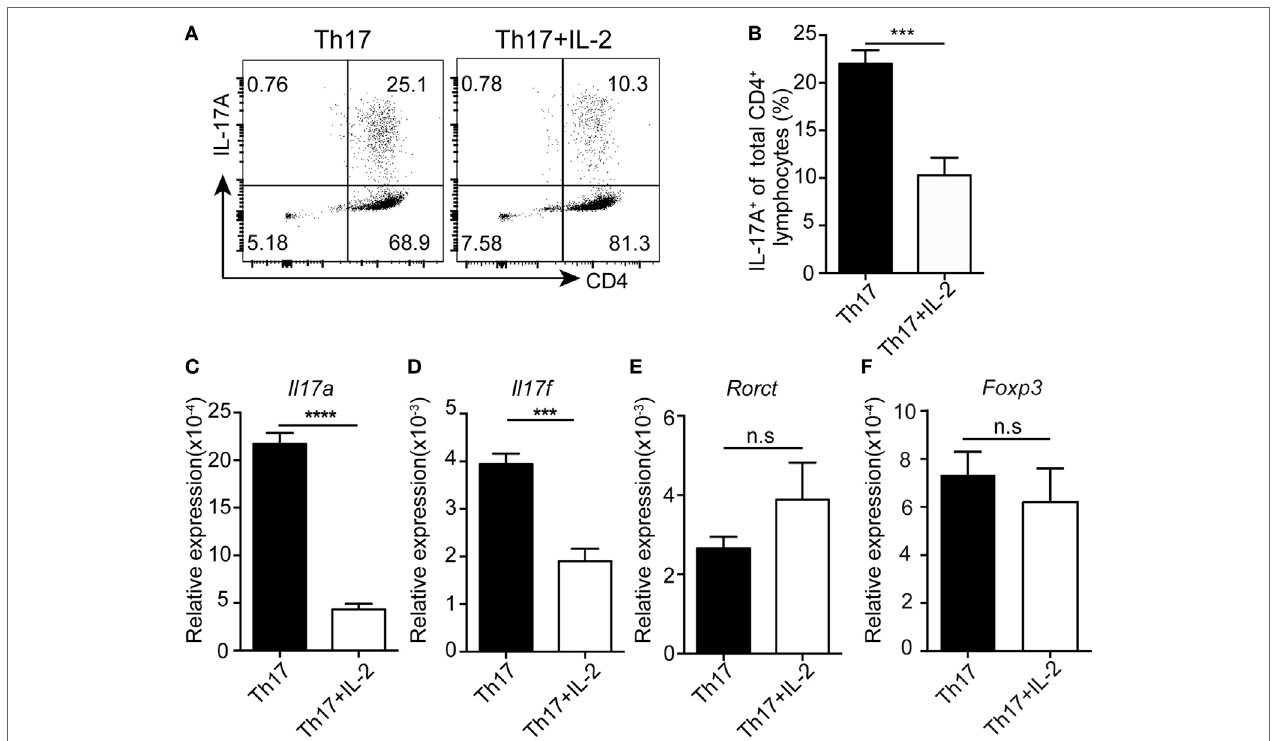
FigUre 3 | IL-2 inhibits human Th17 differentiation without alternation of FOXP3 expression. Naïve CD4 + T cells were stimulated under Th17 conditions with or without IL-2 for 8 days. The percentages of CD4 + IL-17A + cells were determined by intracellular staining (a) . Histogram analysis of the percentages of the differentiated Th17 cells treated with or without IL-2 (b) . mRNA expressions of Il17a (c) , Il17f (D) , Rorct (e) , and Foxp3 (F) genes was assessed by q-PCR in differentiated Th17 cells treated with or without IL-2. *** p <